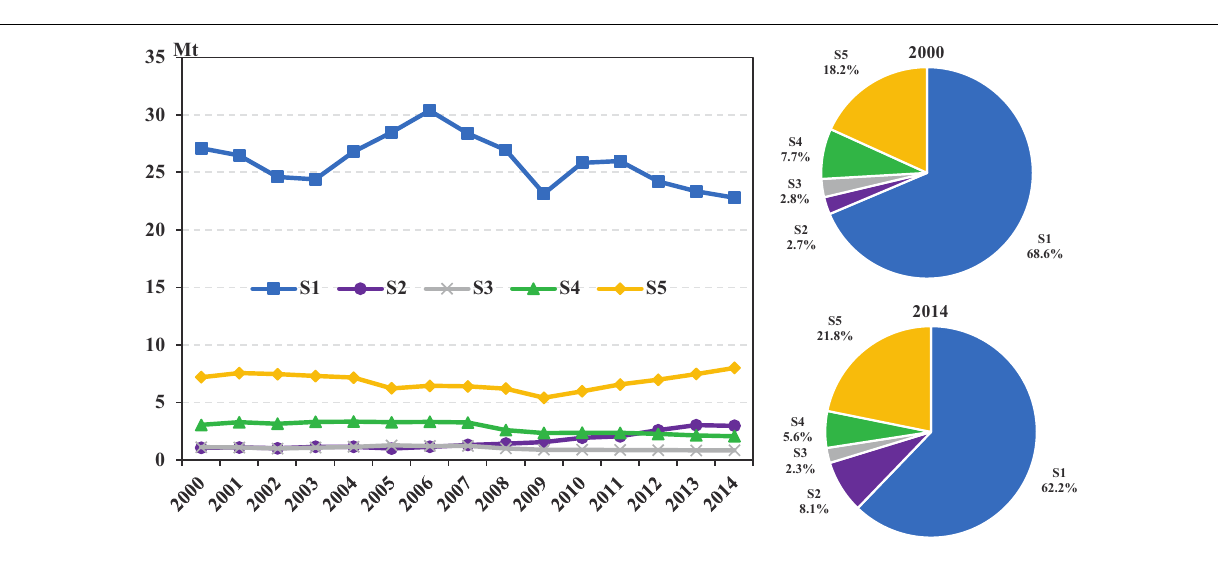
embodied carbon emissions, from 7.7 and 2.8% in 2000 to